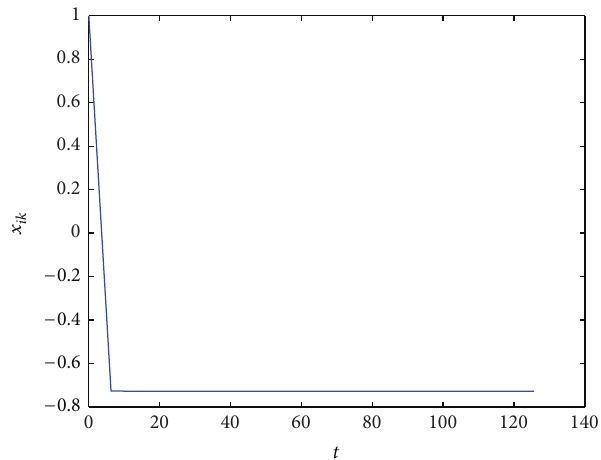
Figure 7: Numerical results for (77) with 𝑐 1 = 1 . 𝑘 = 20